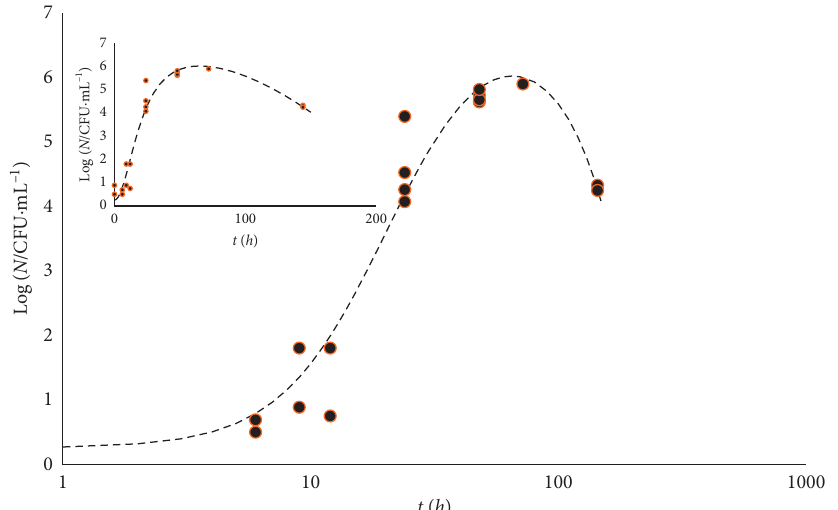
Figure 10: Growth and decay trend of Listeria monocytogenes . The experimental data come from the COMBASE data bank (Com Base ID: Lm_Nat_25C_T3). The fitting curves correspond to equation (11). Log 10 ( N max /CFU · mL − 1 ) � 7.25, c � 429 h 2 , b � 0.14, and d � 7.310 3 h 2 and δ � 2. The insert reports the same data in the time units used in the source.